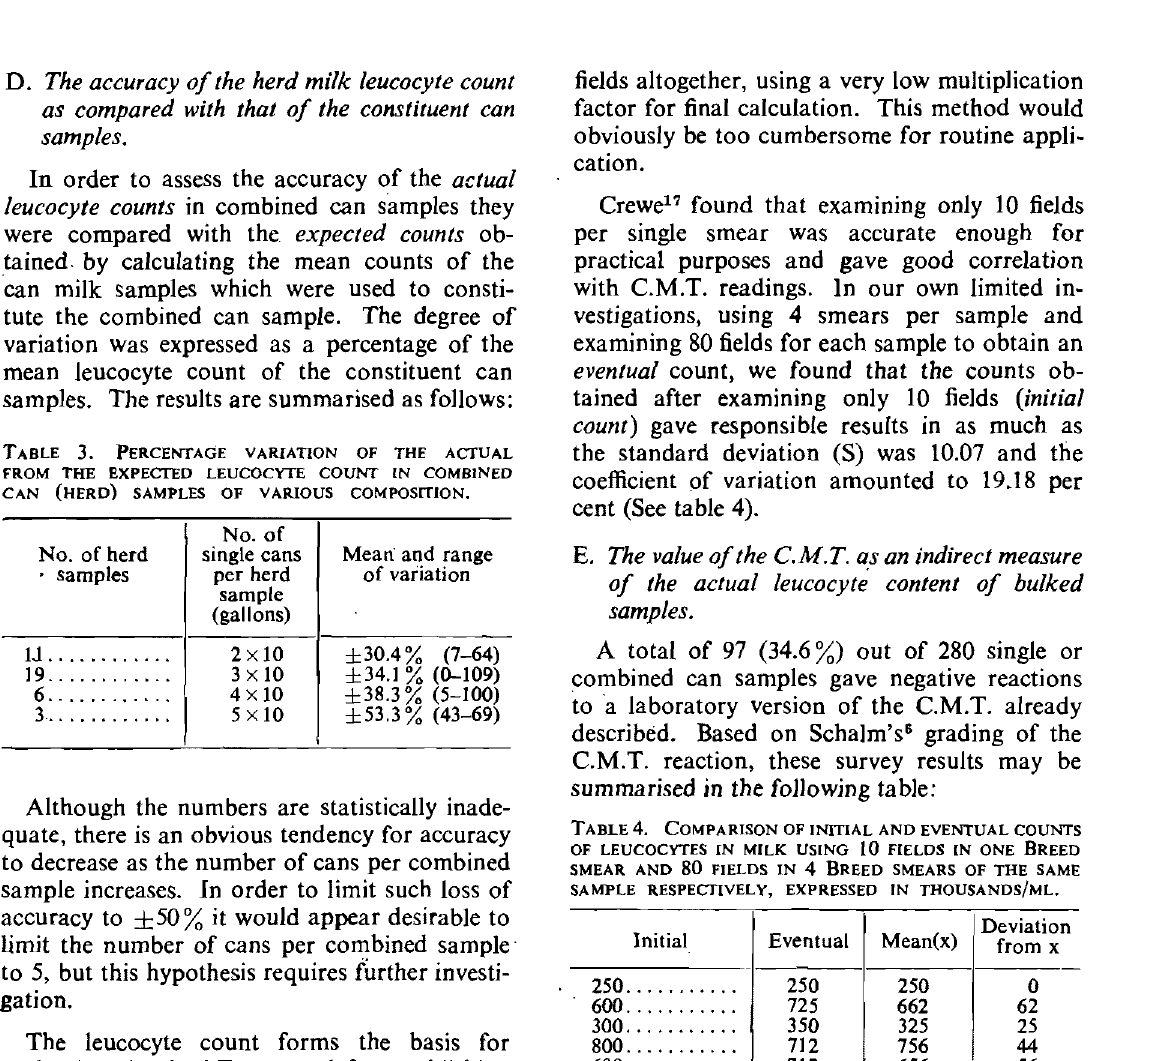
TABLE 4. COMPARISON OF INITIAL AND EVENTUAL COUNTS OF LEUCOCYTES IN MILK USING 10 FIELDS IN ONE BREED SMEAR AND SO FIELDS IN 4 BREED SMEARS OF THE SAME SAMPLE RESPECTIVELY, EXPRESSED IN THOUSANDS/ML.